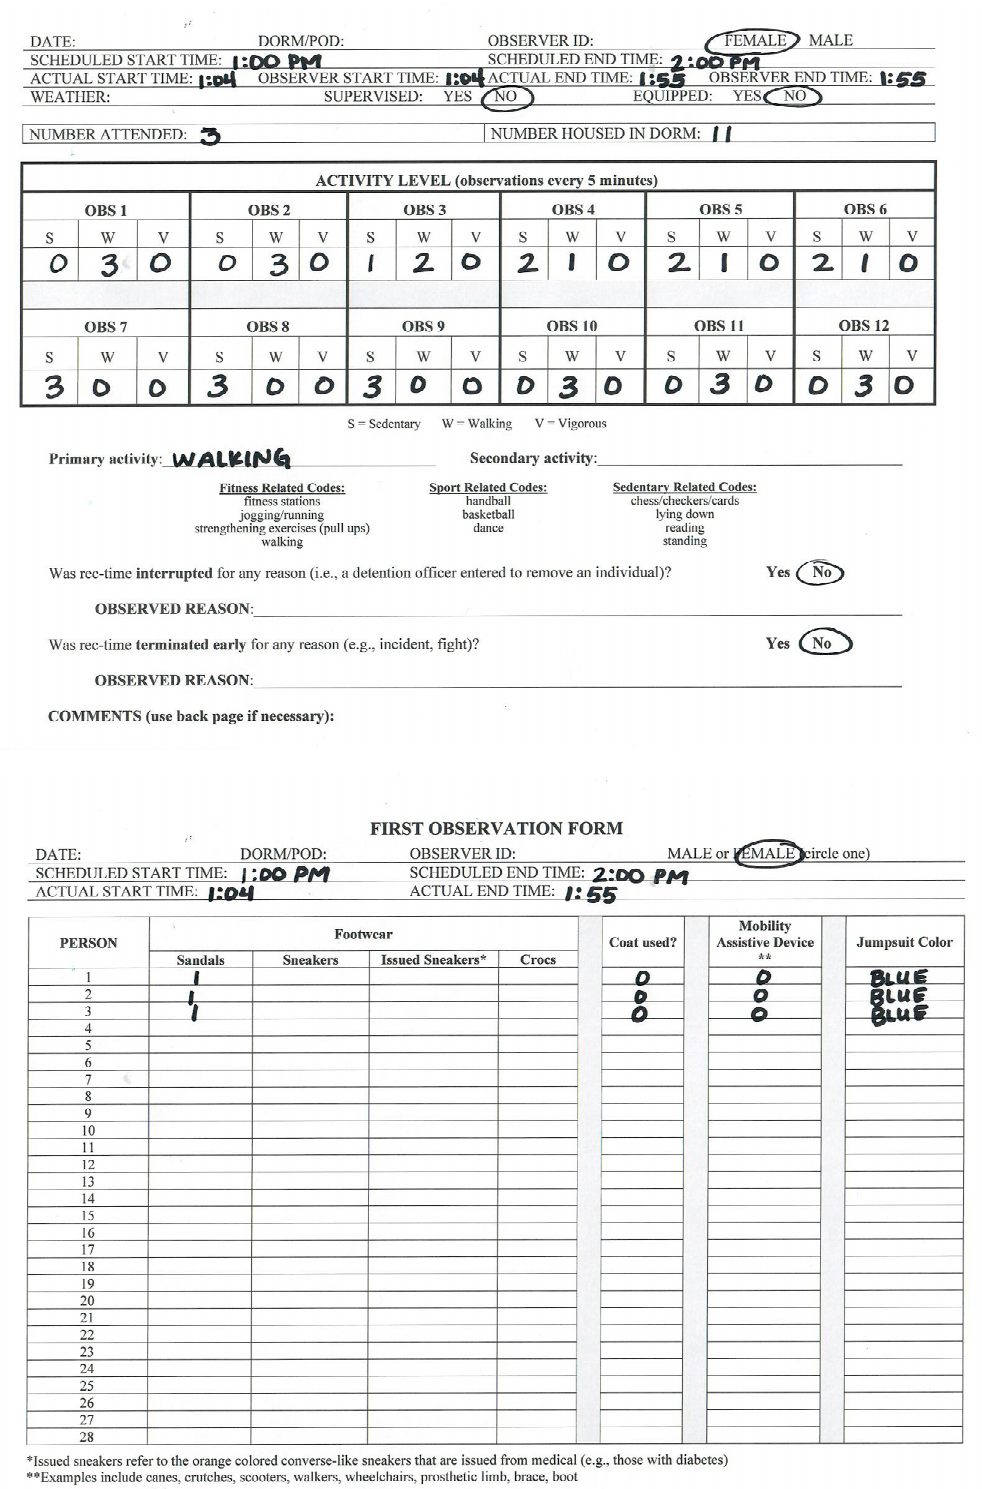
Figure 2. Sample SOPARC data collection